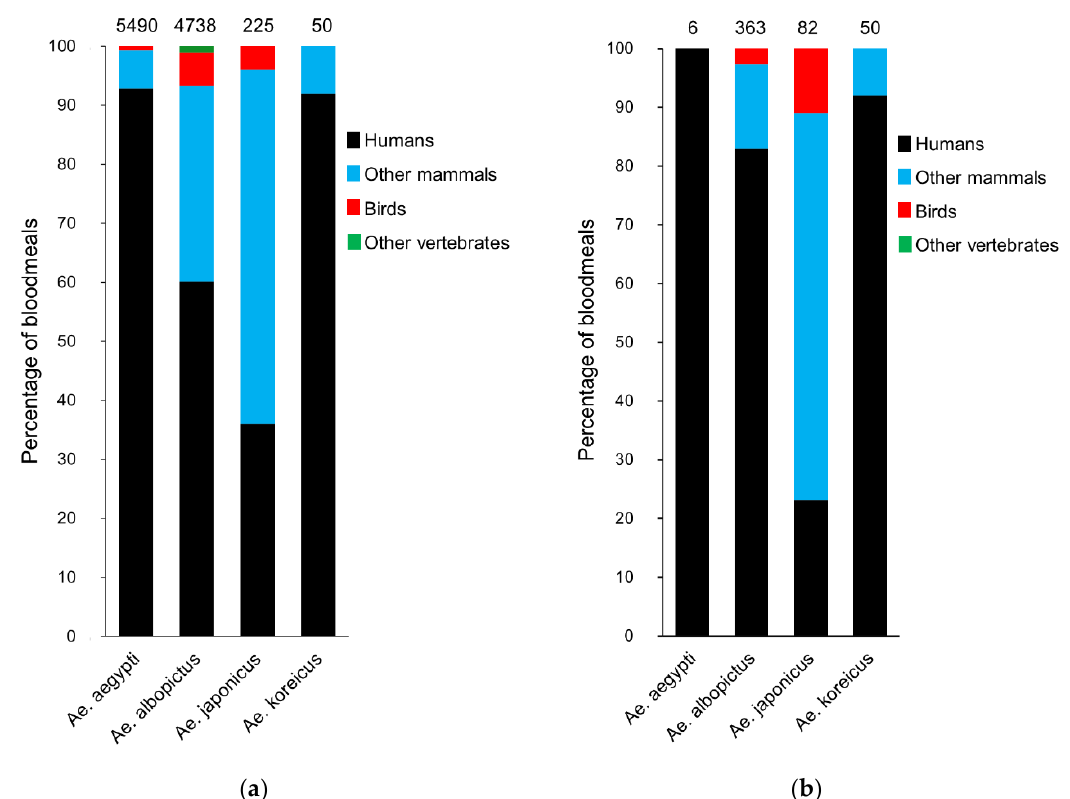
Figure 2. Percentage of blood meals derived from different vertebrate hosts. Percentage of feedings derived from humans (black), other mammals (blue), bird (red) and other vertebrates including reptiles, amphibians and fish (green) for the four Aedes invasive species studied ( a ) in both their native and invaded ranges or ( b ) studies conducted only in Europe. Blood meals derived from more than one vertebrate species (i.e., mixed blood meals) were excluded from the plot. The studies used for this figure are listed in the Supplementary Material Table S1.